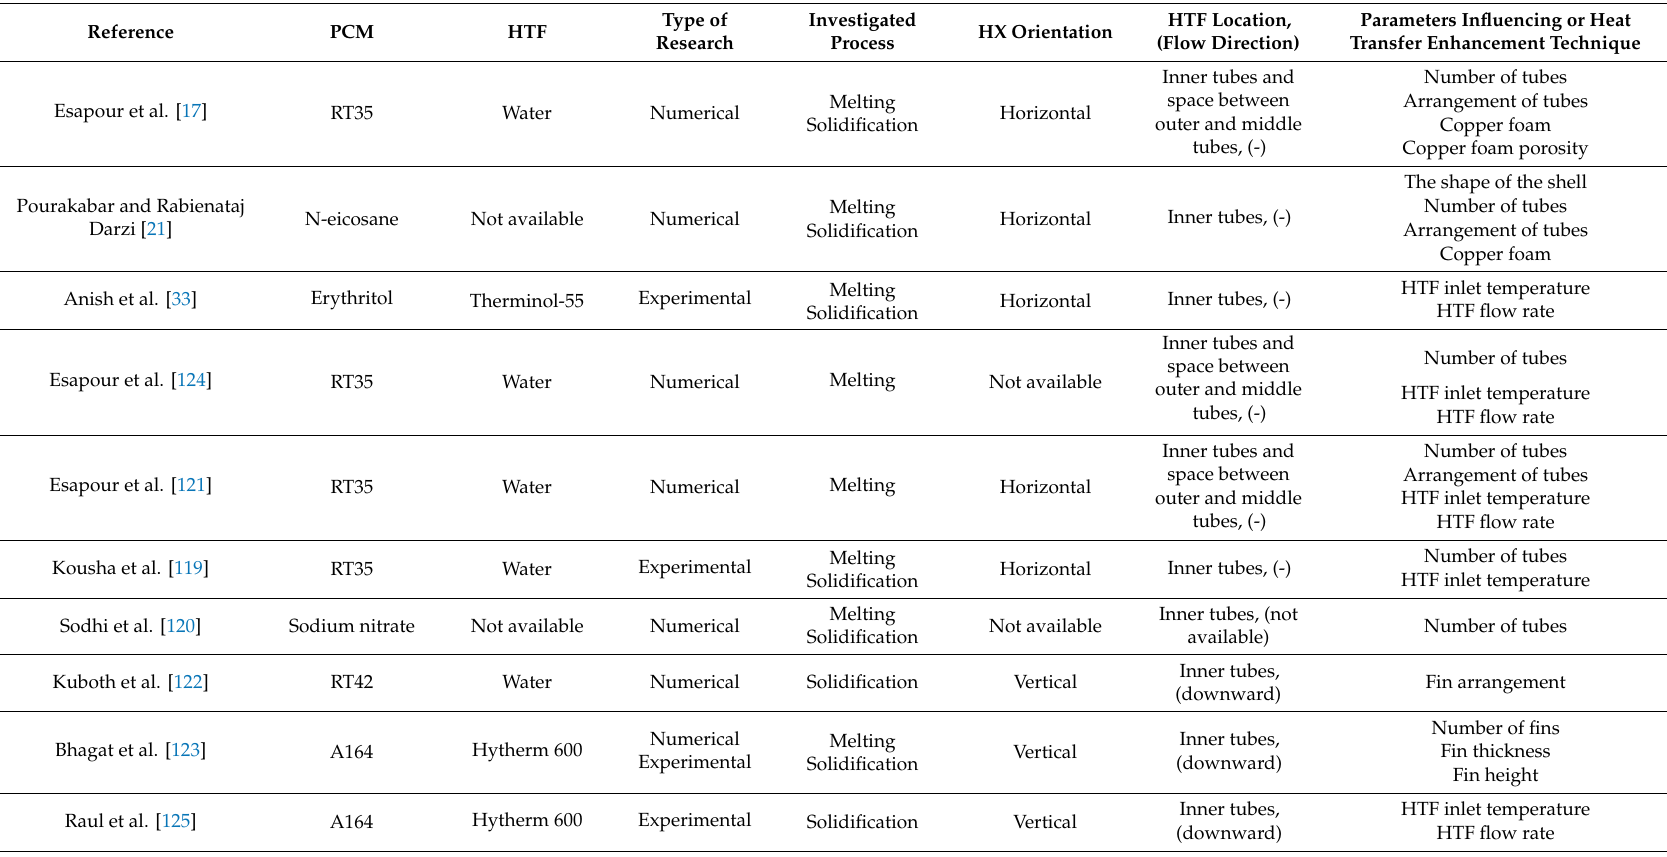
Table 6. Research on the multi-tube heat